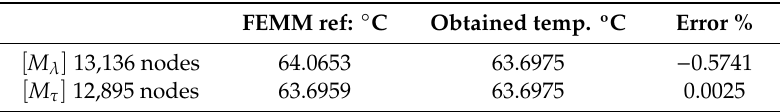
Table 7. Temperature errors using [ M λ ] and [ M τ ]